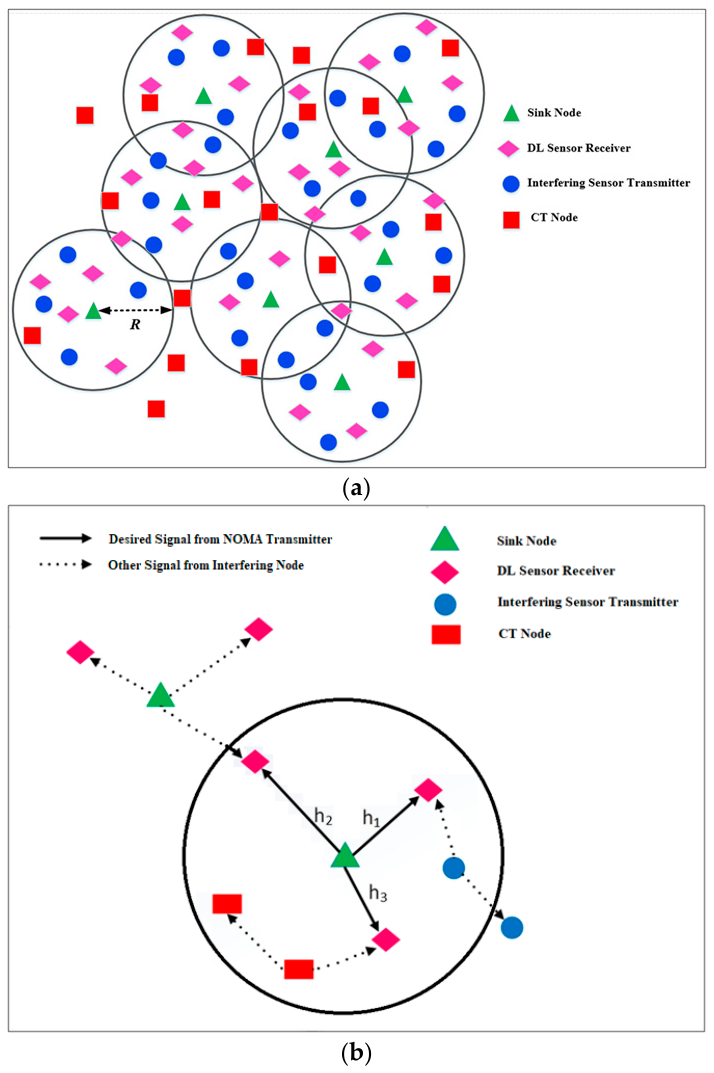
Figure 1. ( a ) A realization of Ξ SE , Ξ SK and Ξ CT transmitter processes; and ( b ) an illustration of sink-to-sensors communication using NOMA under interference of other sink, sensor and CT nodes.